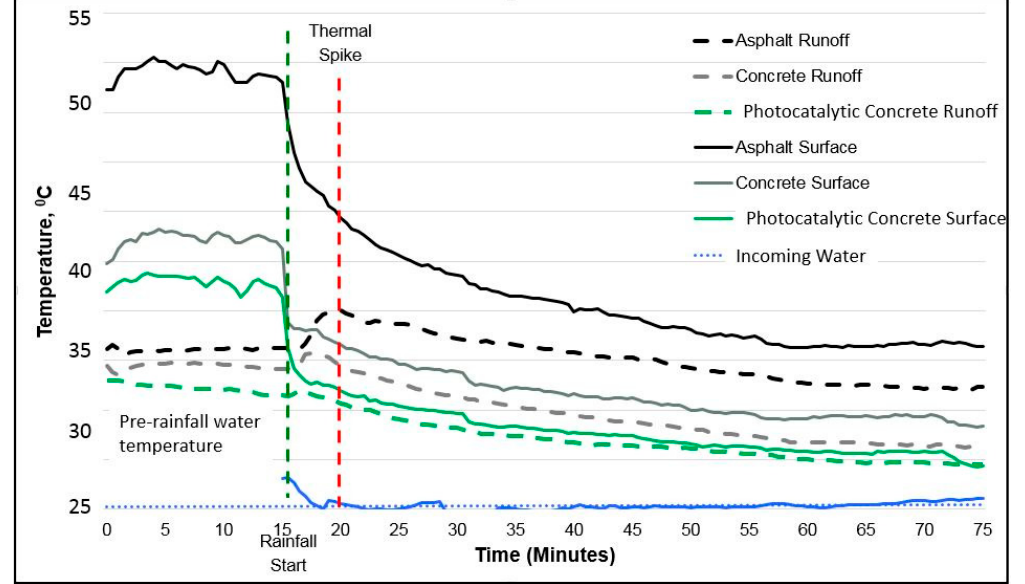
Figure 8. Average impervious surface and water temperatures by the thermal probe at the outdoor field study site, Auburn University, Auburn, Alabama, 2013. field study site, Auburn University, Auburn, Alabama,